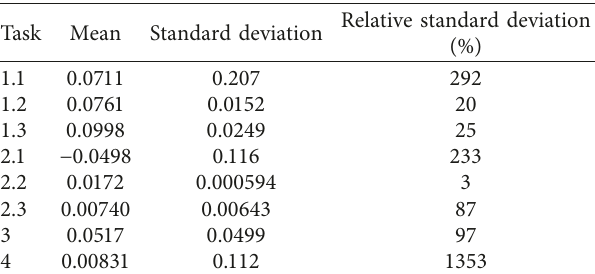
Table 7: Statistical analysis of _ ς